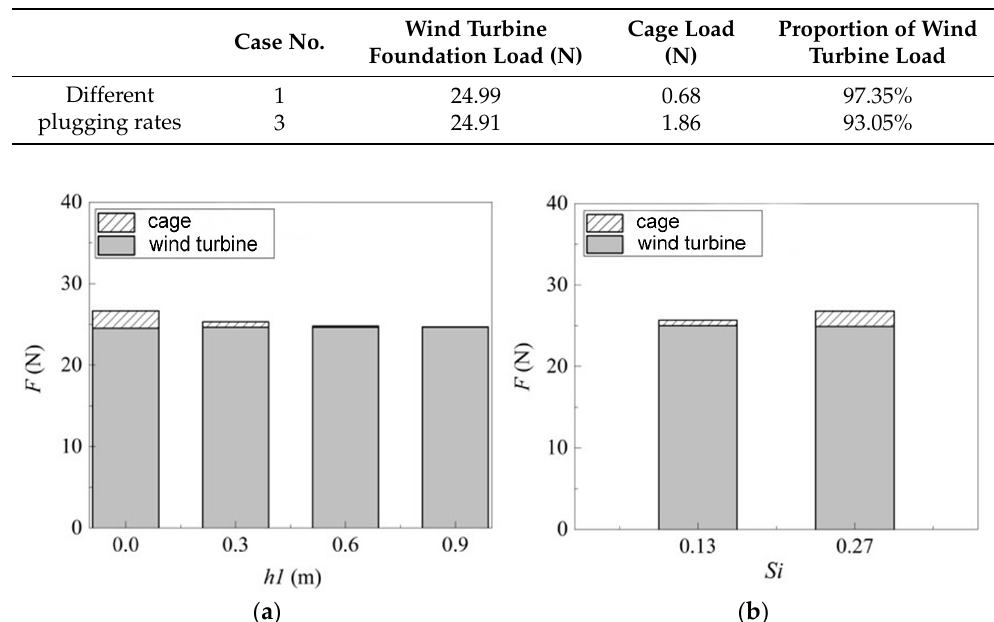
Figure 14. Hydrodynamic load distribution on the combined structure under different cage submergence depths ( a ) and cage plugging rates ( b ). Table 6. Distribution and proportion of the maximum horizontal load on the combined structure caused by different cage submergence depths and cage plugging rates.